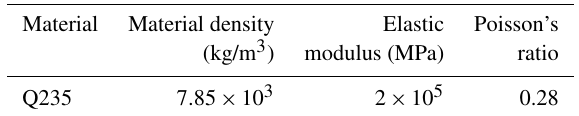
Table 2. Manipulator material